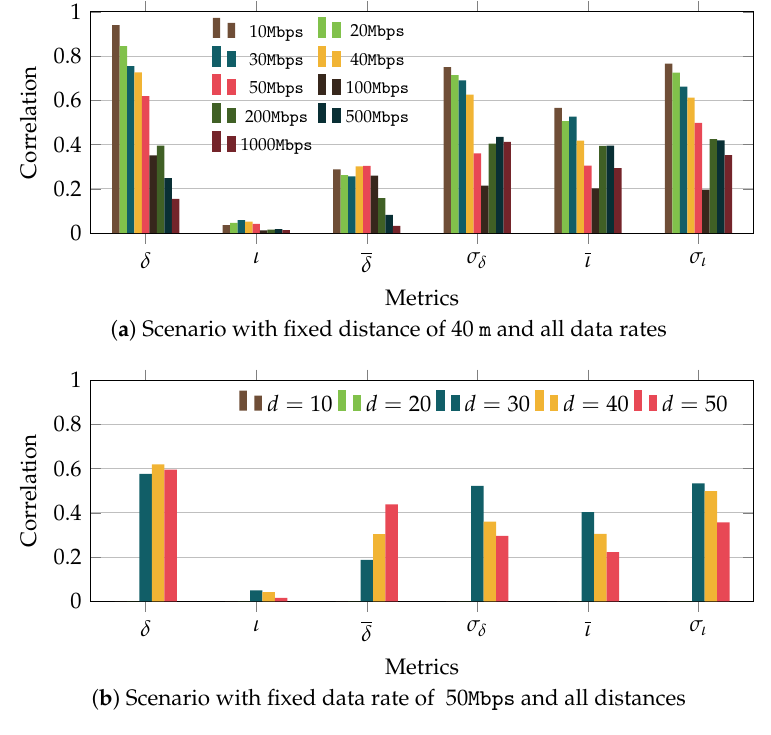
Figure 6. Correlation of all metrics with